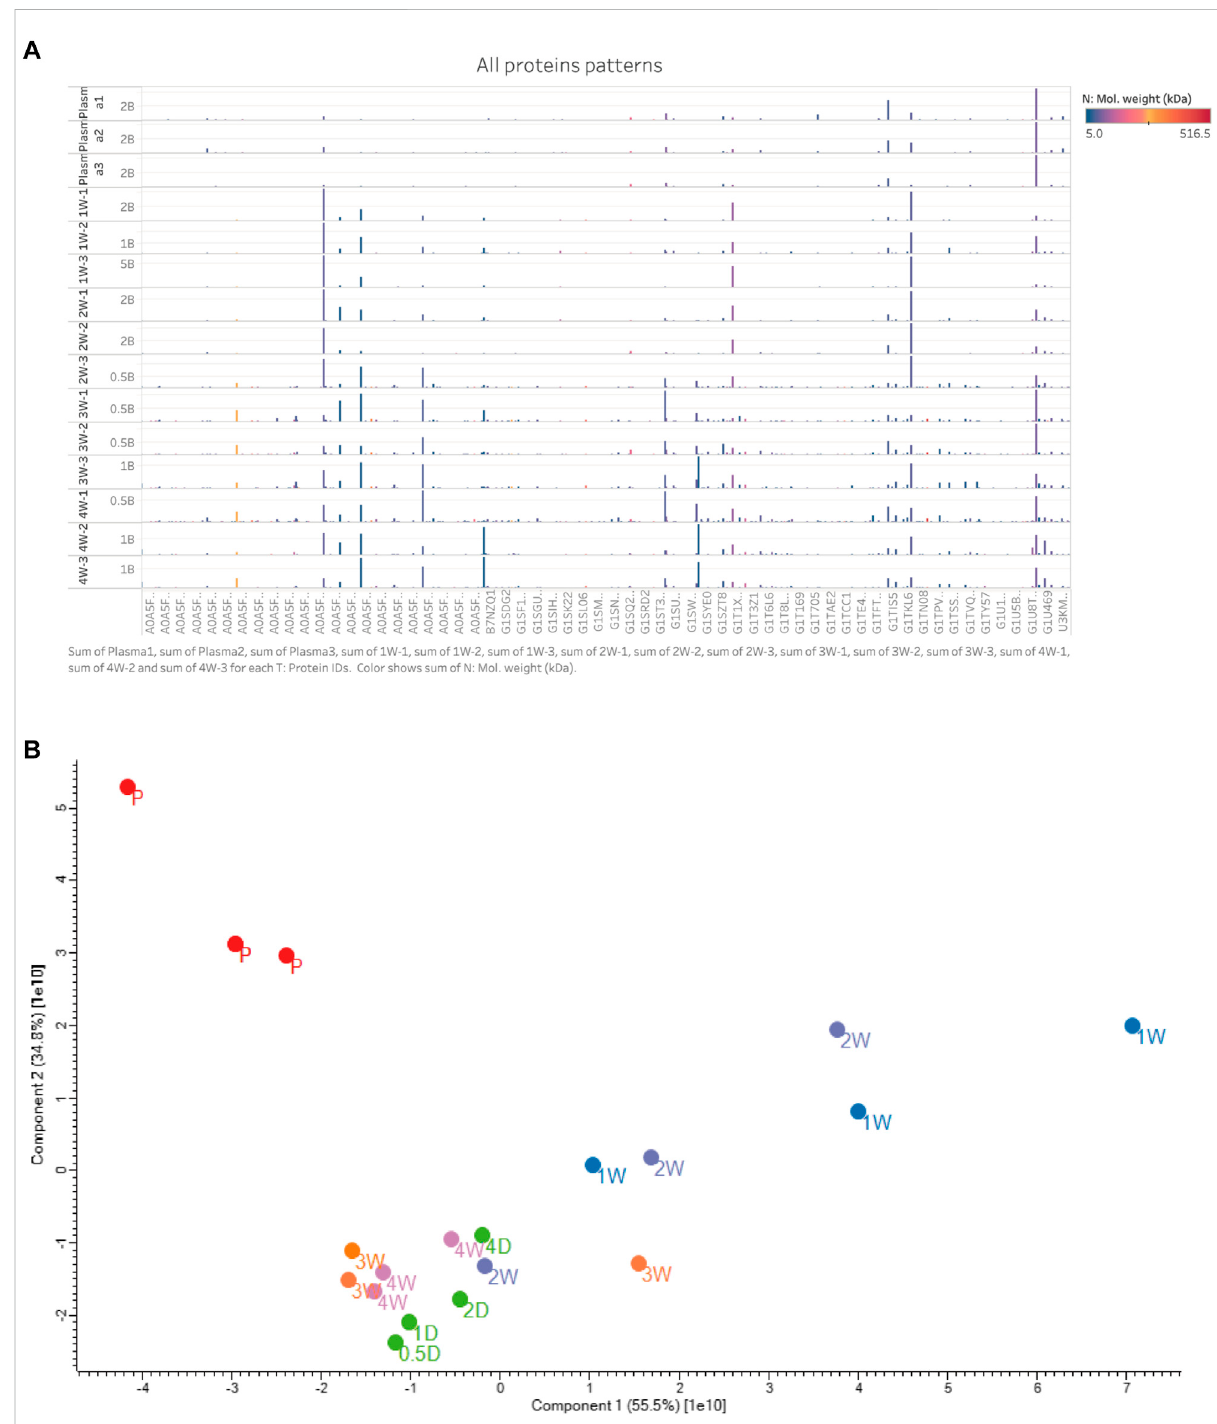
FIGURE 4 (A) All protein patterns with replicated samples. The y -axis was the 12 stable neointima samples (day 7, 14, 21, and 28, each n = 3) and 3 plasma samples (up 3 samples); The x -axis was partial the proteins ’ gene name (too many to display); The protein pro fi les of neointima were not correlated with the plasma. And late-stage samples (3w and 4w) show more quantitation and types of proteins than others. Most abundance proteins in neointimawerewithlowmoleculeweight.Colormeansthemoleculeweight.Hightistheproteinsexpressedquantitation.Protein ’ snameisnot shown. (B) PCA map of all the samples in plasma and neointima